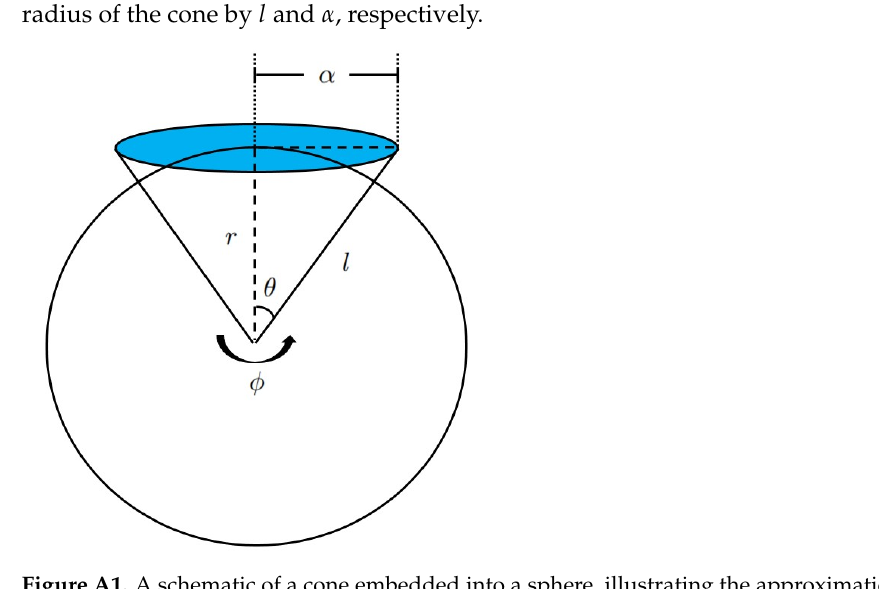
Constraining the apex angle of the cone to be small, θ (cid:28) 1, the following relations hold: tan θ = α / r (in general) and tan θ ≈ θ , together giving α ≈ r θ . Fixing r = r 0 , one also has α ≈ r 0 θ and d α ≈ r 0 d θ . The line element describing the base of the cone is then (cid:1) (cid:0) d θ 2 + θ 2 d φ 2 ds 2 = d α 2 + α 2 d φ 2 ≈ r 2 , which is precisely 0